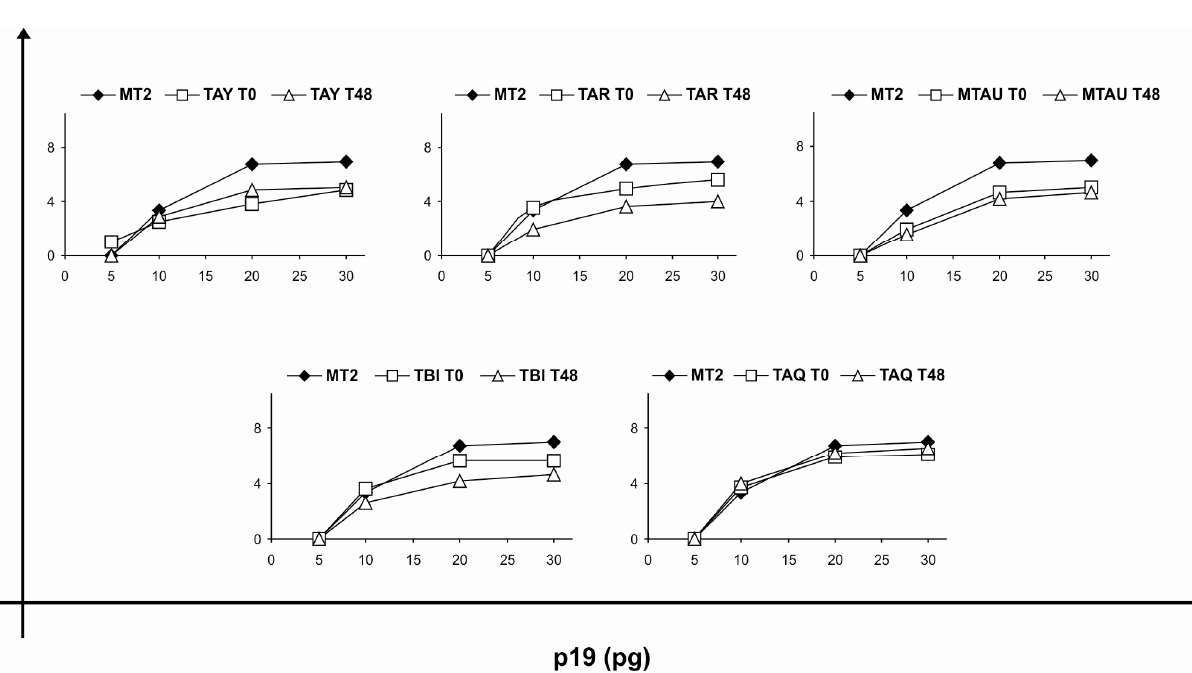
Figure 1. RT activity in human T-lymphotropic virus type 1 (HTLV-1) isolates from peripheral blood mononuclear cell (PBMC) cultures of HTLV-1-associated myelopathy (HAM) patients. Centrifuge-enriched isolates from PBMC cultures of 5 patients with HAM (TAY, TAR, TAU, TBI, TAQ), before (T0) and after (T48) therapy with 3TC plus AZT, or from MT-2 cells, were assayed for p19. Serial dilutions of p19-equivalent isolates were added to the RT assay and amplified products of the template were visualized on a 2% agarose gel and quantitated by densitometry, as a measure of RT